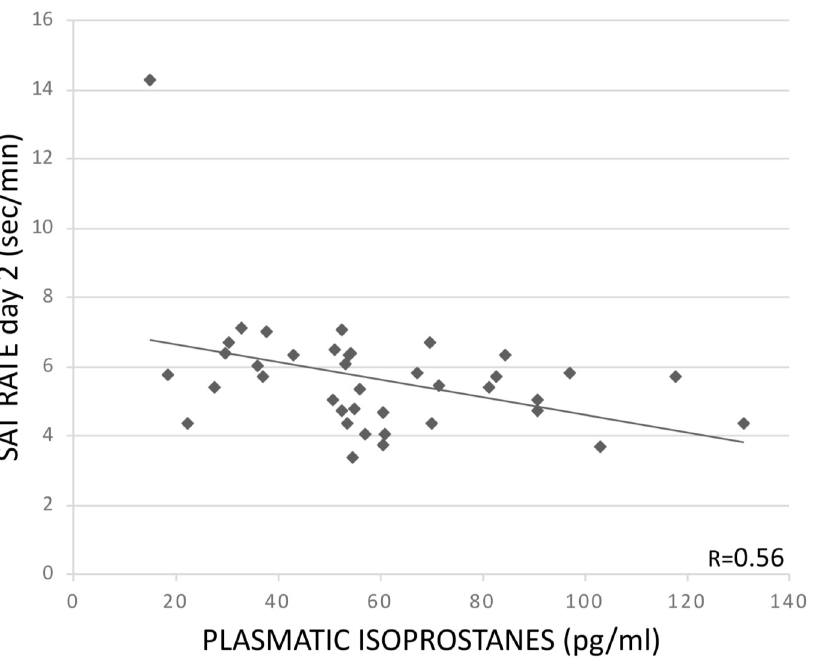
Figure 2. Association between pl-IPs between 24 and 48 h after birth and SAT RATE at day 2 (min) ( p = 0.006).